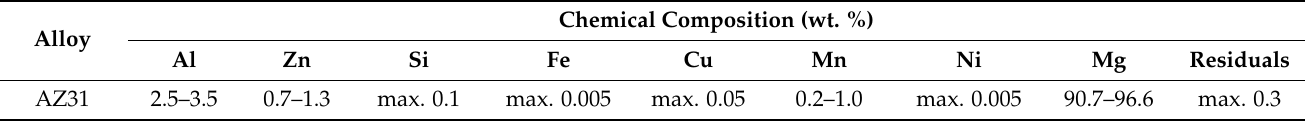
Table 1. Chemical composition of wrought AZ31 magnesium alloy [32]. Chemical Composition (wt.